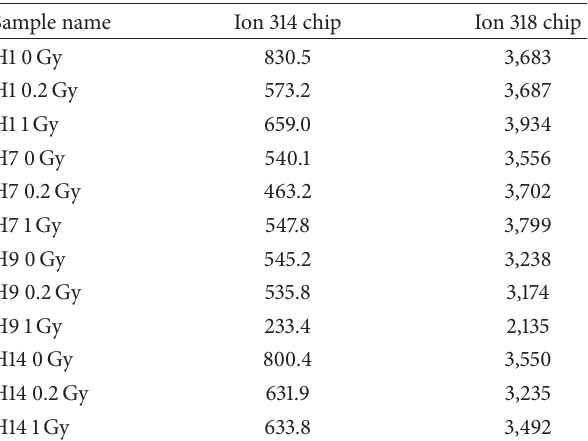
Table 2: Mean depth